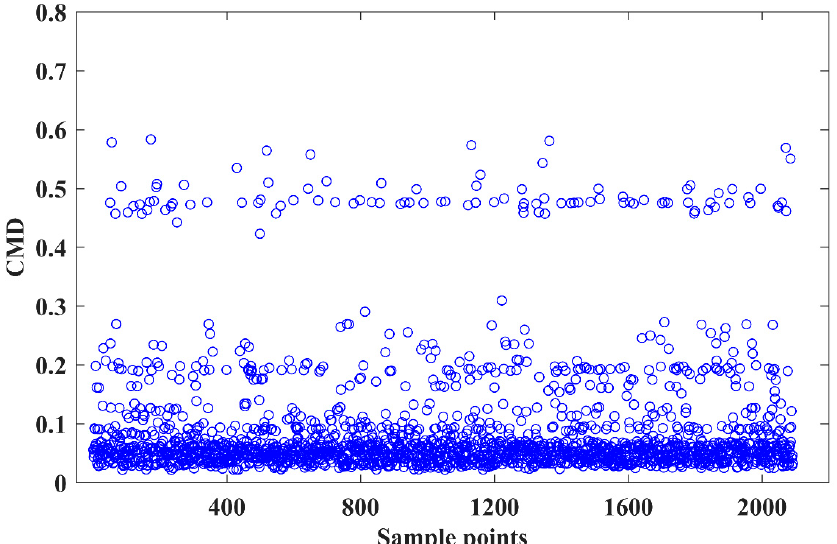
Figure 6. The distribution of the condition monitoring directive (CMD).